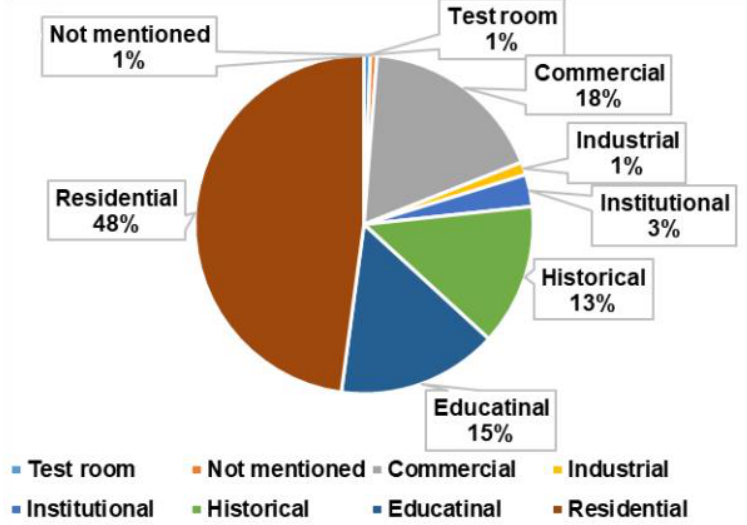
Figure 2. Building type percentages among case studies [23].